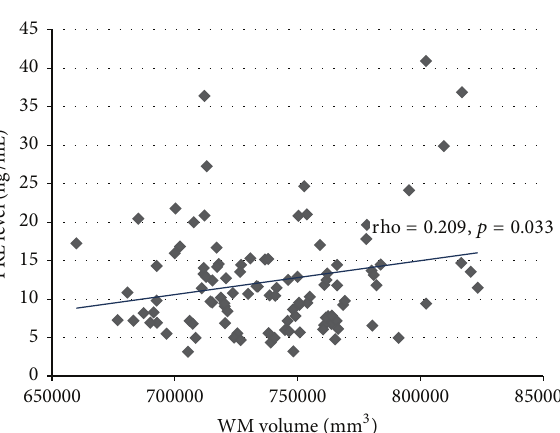
Figure 1: Relationship between PRL plasma levels and WM volume.